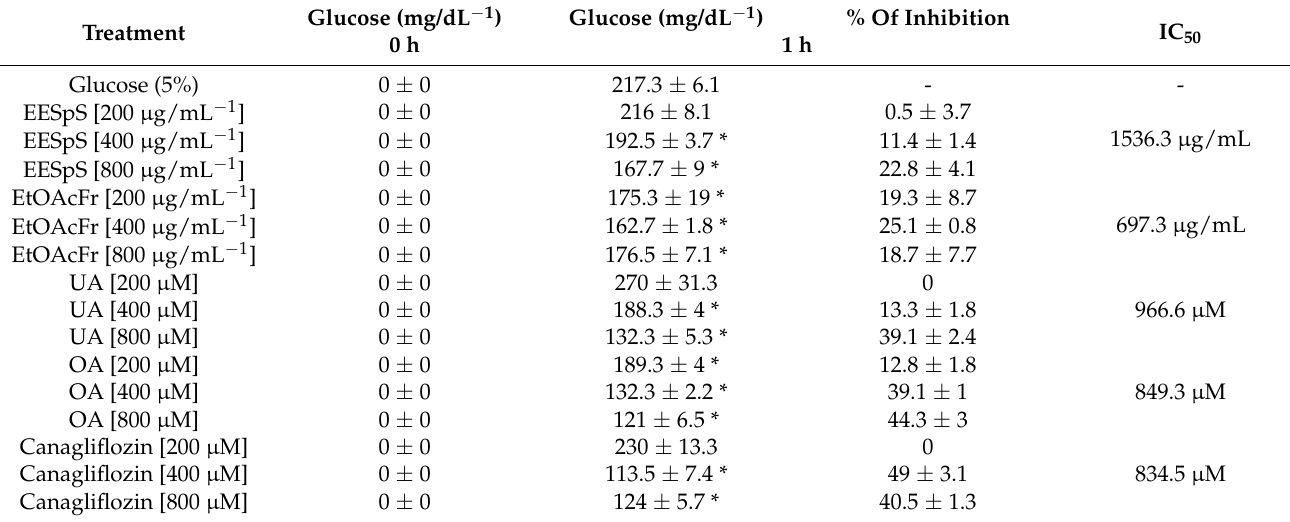
Table 4. Quantity of glucose measured in the external aqueous medium, percent inhibition, and CE 50 calculated after addition of treatments on intestinal glucose absorption (IGA) inhibition